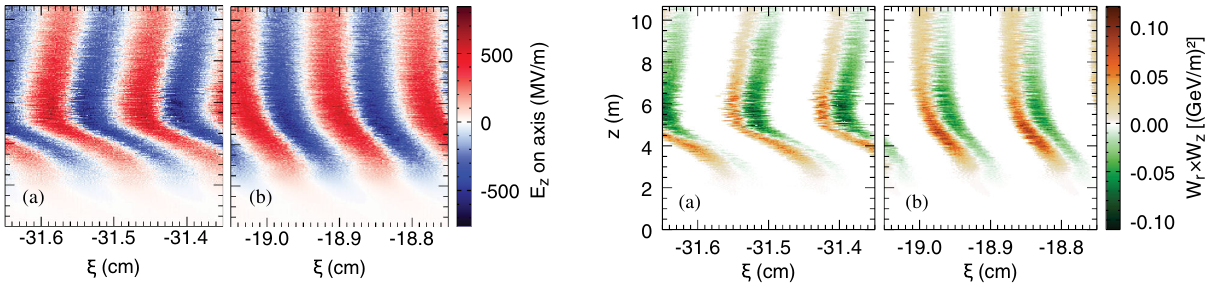
FIG. 4. Waterfall plots of the product of the transverse and for (a) ξ ≈ − 2 . 5 σ zb longitudinal forces W r and W z at r ¼ 0 . 7 k − 1 pe and (b) ξ ≈ − 1 . 5 σ zb , shown only for the accelerating regions ( W z > 0 ). The orange areas ( W r > 0 ) are defocusing for elec- trons and the green areas ( W r < 0 )